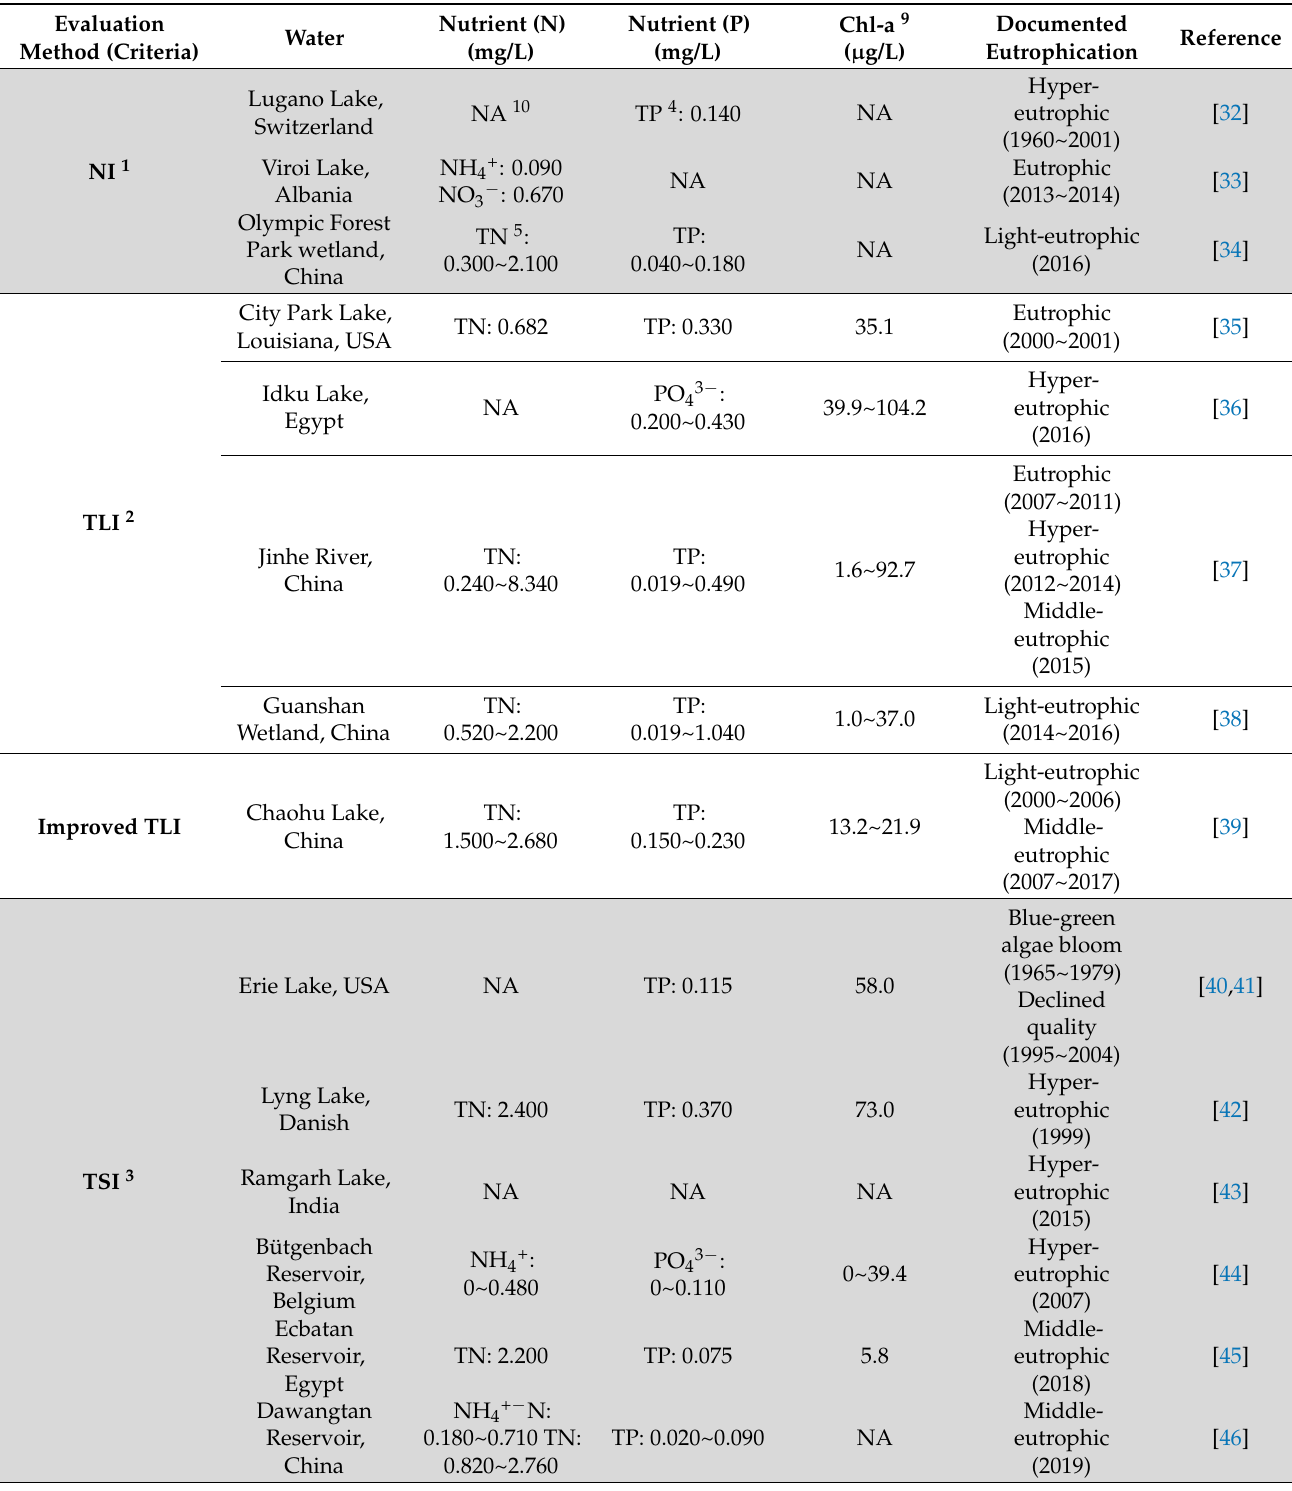
Table 1. Nutritional status of water eutrophication and evaluation method (criteria) in lakes, reservoirs, rivers, and freshwater